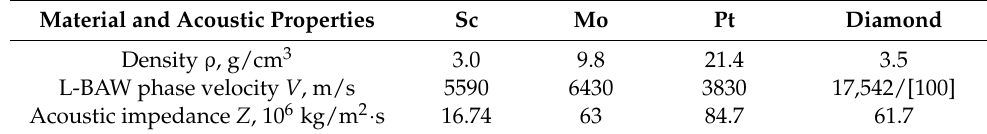
Table 2. Properties of diamond and metals chosen for